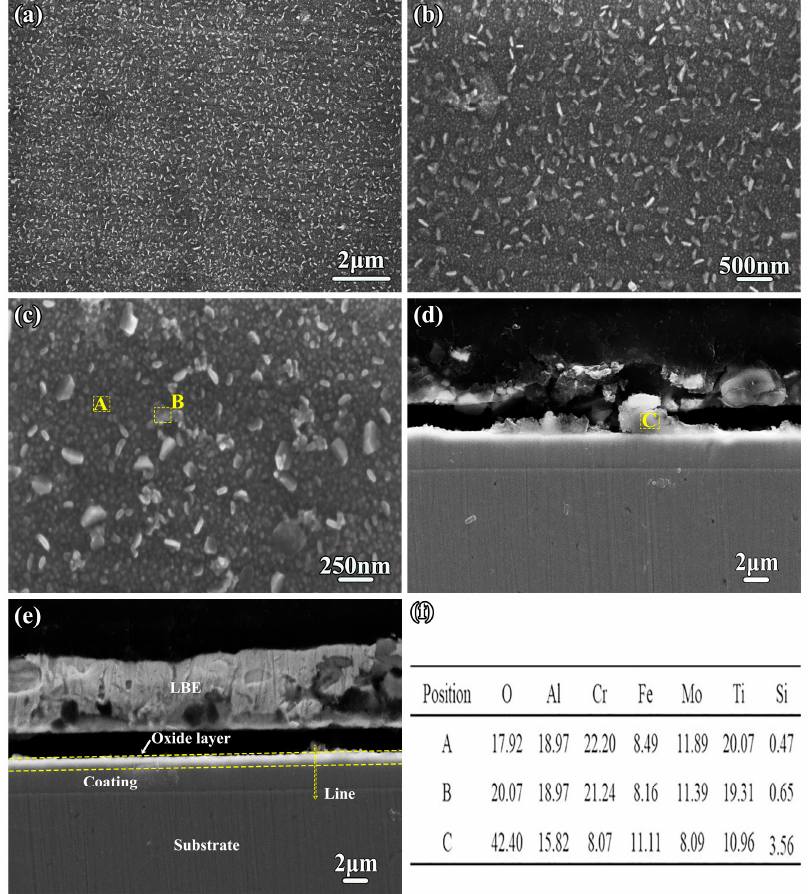
Figure 8. ( a – c ) SEM surface and ( d , e ) cross sectional images of the as − deposited AlTiCrFeMoSi HEA coating at 550 °C for 500 h; ( f ) EDS analysis of the microzone shown in ( c , d ).